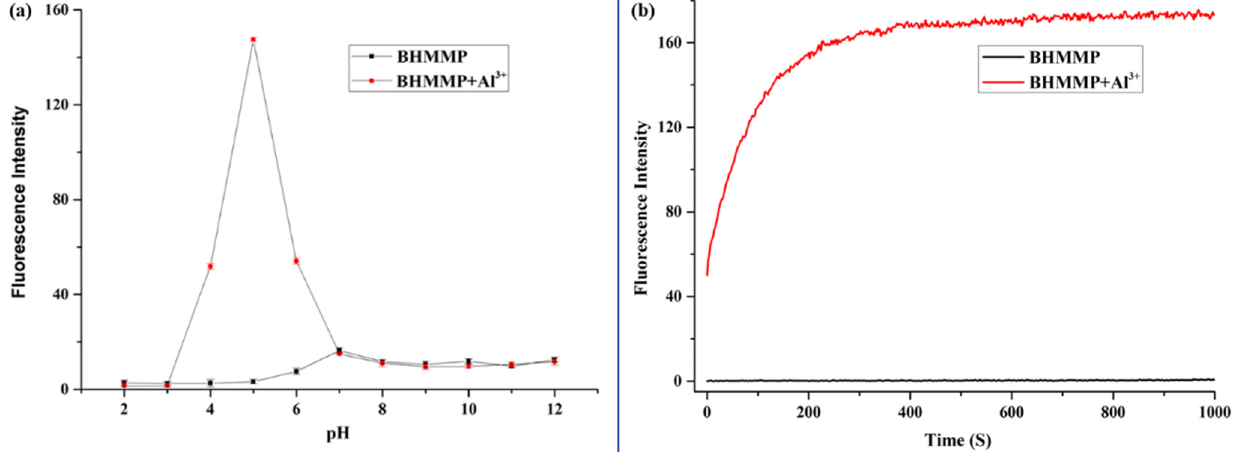
Figure 9. ( a ) Effect of pH on the fluorescence intensity of BHMMP and the BHMMP –Al 3+ complex, λ ex =370 nm. ( b ) Time-dependent fluorescence intensity changes of BHMMP (10 µM) to Al 3+ (50 µM) at 522 nm.